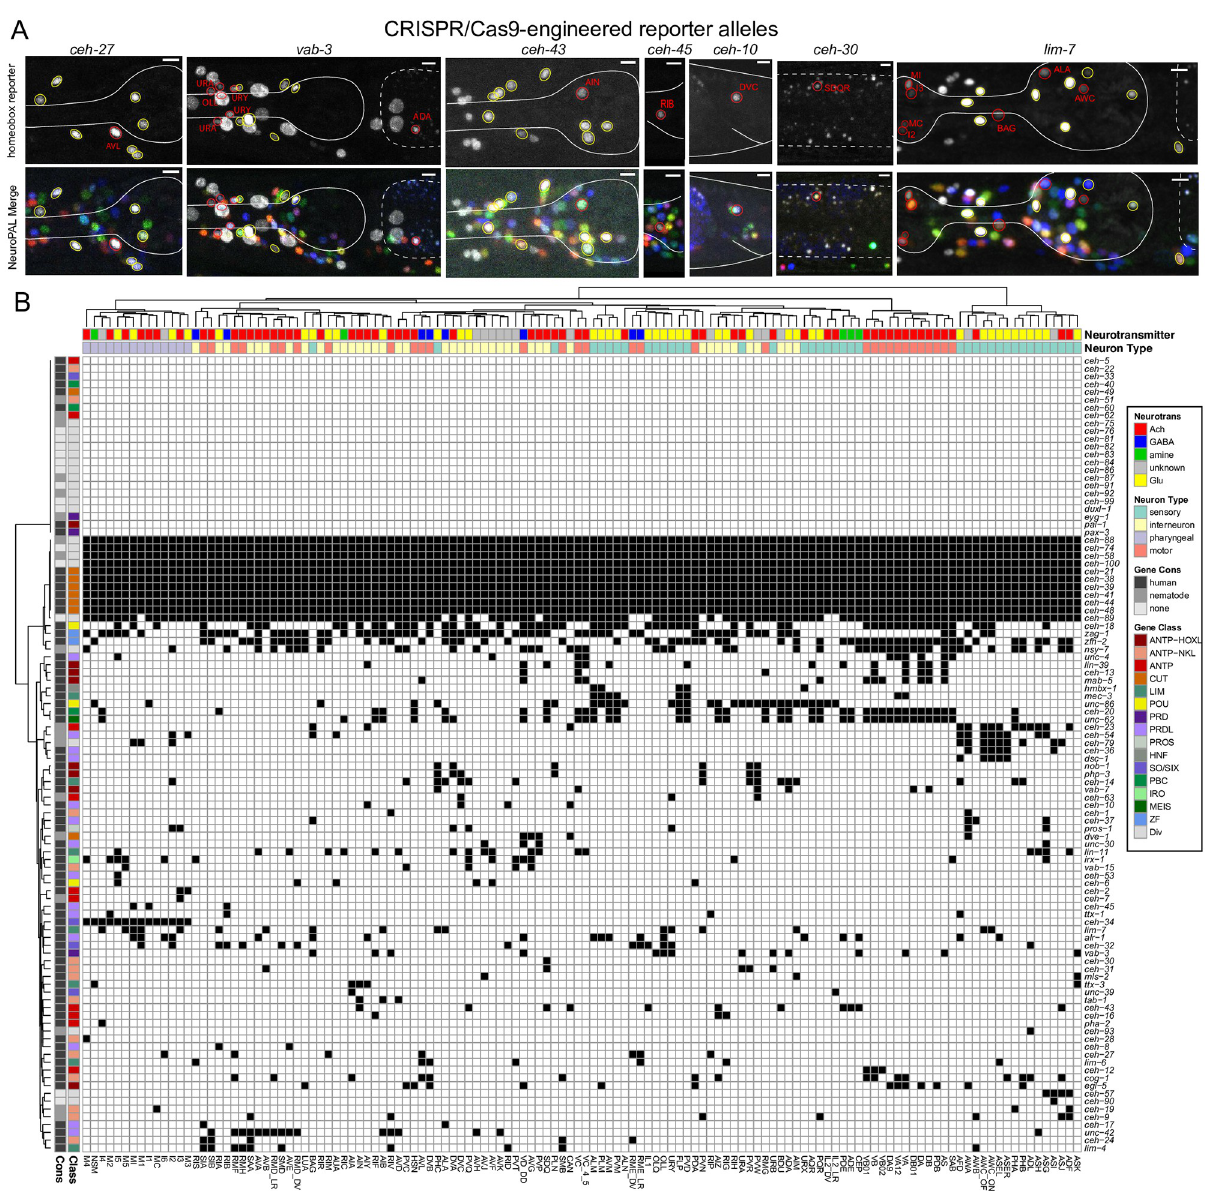
Fig 1. Updated expression of the homeobox gene family with reporter alleles. Fig 1A: Representative images of homeobox reporter alleles, generated by CRISPR/Cas9 genome engineering (see strain list in S5 Table) with different expression than previously reported fosmid-based reporter transgenes. Neuron classes showing expression not previously noted were identified by overlap with the NeuroPAL landmark strain, and are outlined and labeled in red. Neuron types in agreement with previous reporter studies are outlined in yellow. Head structures including the pharynx were outlined in white for visualization. Autofluorescence common to gut tissue is outlined with a white dashed line. An n of 10 worms were analyzed for each reporter strain. Scale in bottom or top right of the figure represents 5 μ m. See also S1 Fig for more information on ceh-30 and ceh-31 . Fig 1B: Summary of expression of all homeobox genes across the C . elegans nervous system, taking into account new expression patterns from panel A and all previously published data [6]. Black boxes indicate that a homeodomain transcription factor is expressed in that given neuron type and white boxes indicate that a homeodomain transcription factor is not expressed in that given neuron type. Neuron types along the x axis are clustered by transcriptomic similarity using the Jaccard index (see methods) and homeobox genes along the y axis are clustered similarly by their similar expression profiles in shared neuron types. See S3 Fig for numerical representation of homeoboxes per